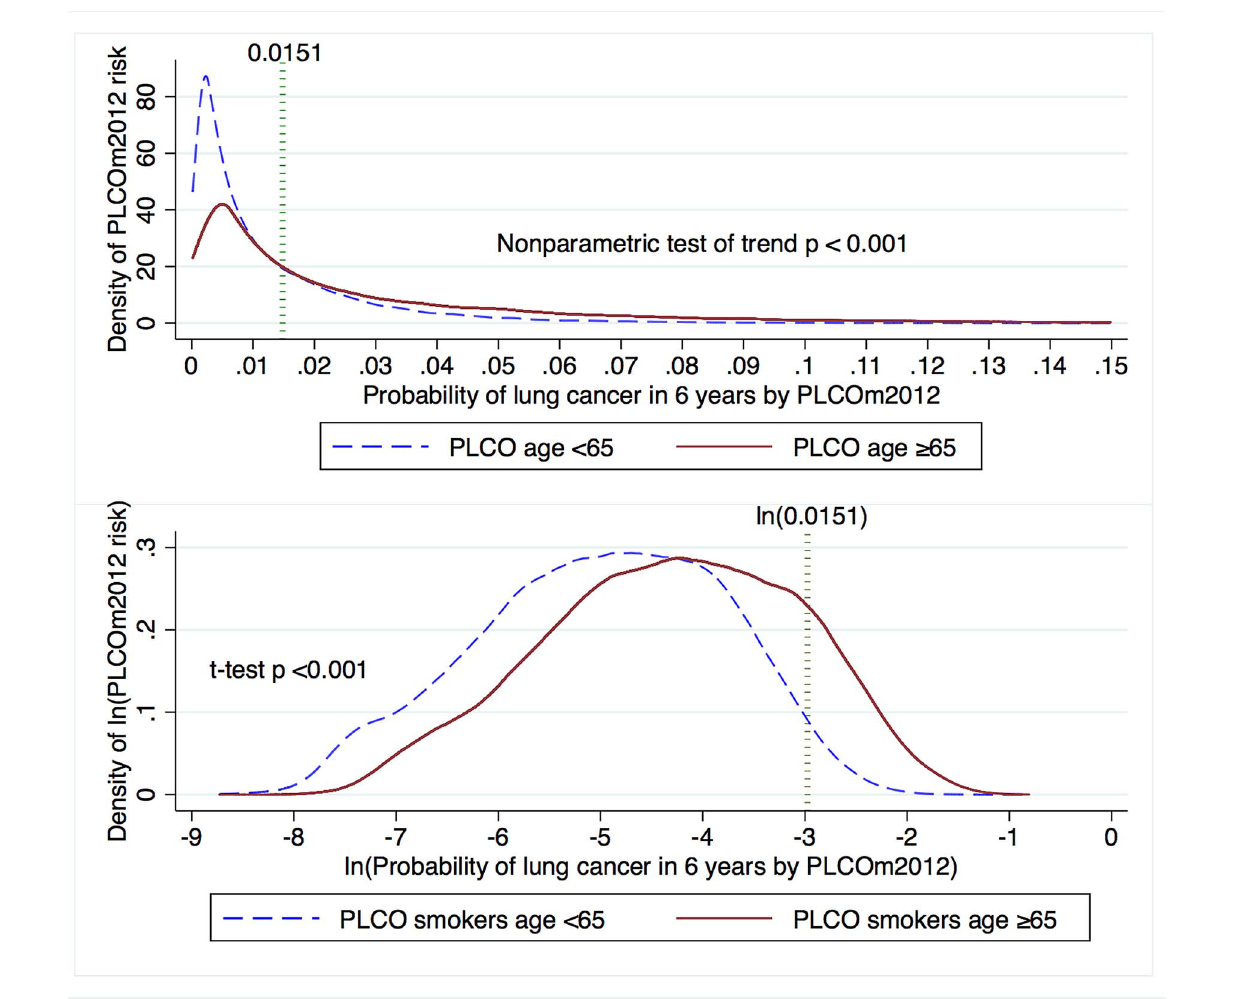
Figure 7. Distribution of PLCO m2012 risk and natural log-transformed risk in PLCO participants stratified by age dichotomized at 65 y. The PLCO m2012 risk $ 0.0151 threshold is marked by the dotted vertical line. The upper graph is right-truncated. PLCO m2012 is the lung cancer risk prediction model described in [11].